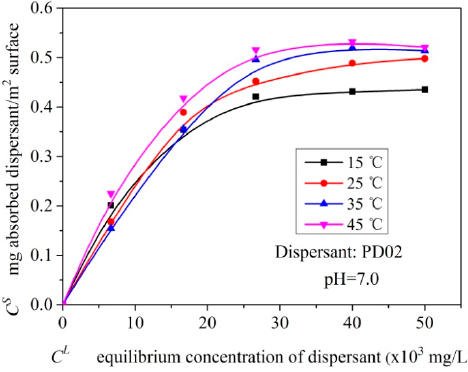
Figure 9. The adsorption isotherms for dispersants PD02 adsorbed on the surface of pigment parti- cles at different temperatures. Table 4. Parameters simulated by the Langmuir equation and Freundich equation.